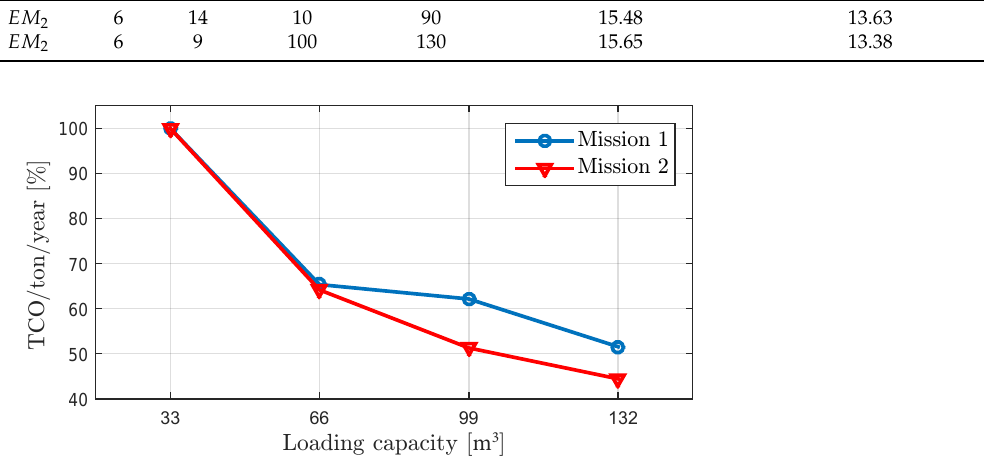
Figure 18. Comparison of annual TCO savings per ton for different vehicle sizes, in case of exclusively using one vehicle size in the fleet making maximum number of trips per day within 16 h. Vehicles with 132-m 3 . loading capacity demonstrate an average 53% reduction in TCO compared to vehicles with a 33-m 3 loading